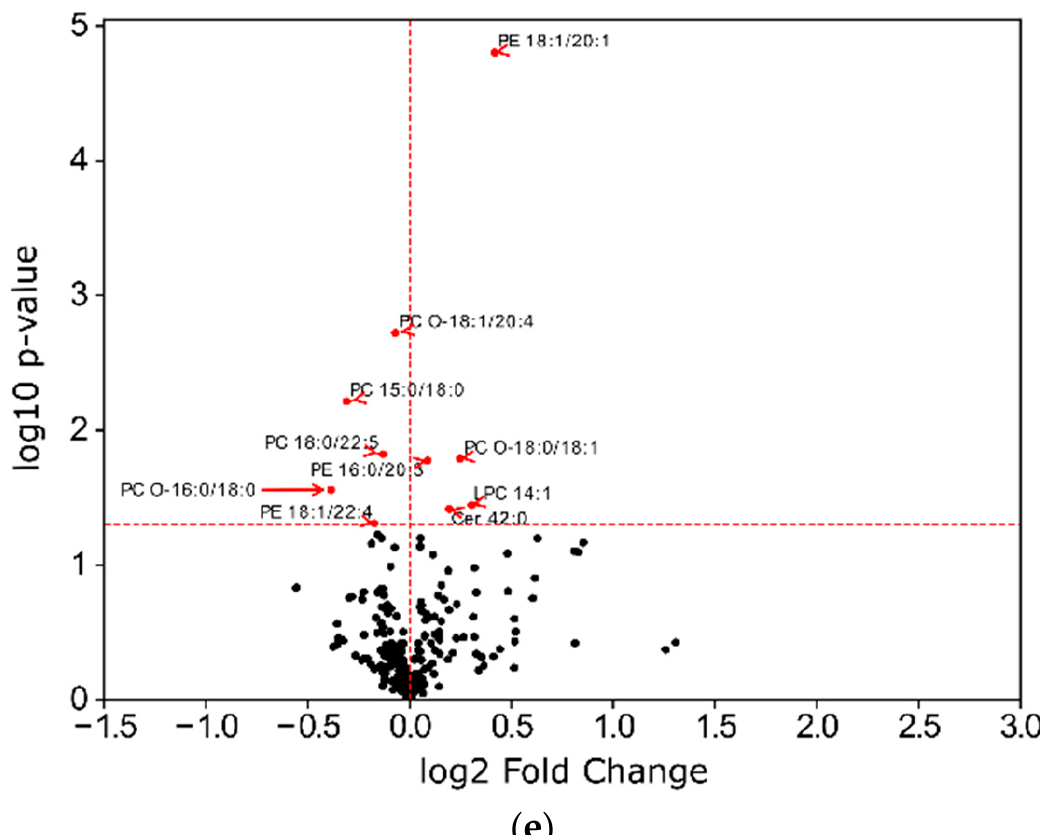
Figure 7. Volcano plot of lipid subspecies of the control group versus groups treated by ( a ) Ticagrelor, ( b ) Metabolite, ( c ) Tica + ADP, ( d ) Meta + ADP and ( e ) ADP. p -values were calculated by one way ANOVA. The dashed red horizontal line represents p -value > 0.05.